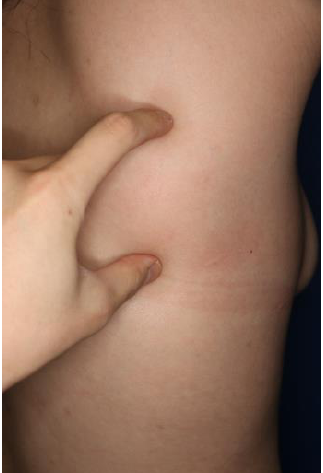
Figure 1. Preoperative photograph of a 34-year-old woman with a palpable mass on the right side of her back.